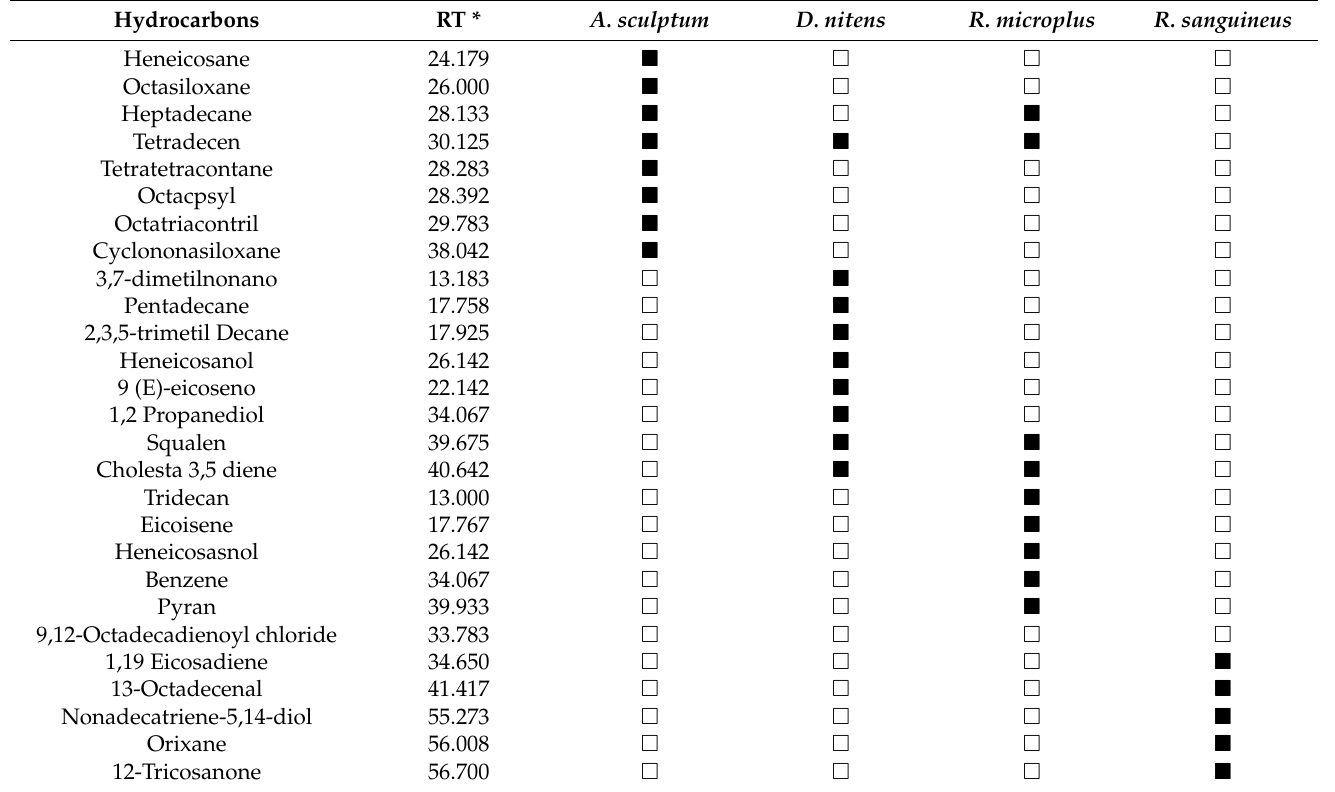
Table 1. Hydrocarbons identified from the cuticles of the ixodid ticks: Amblyomma sculptum , Dermacen- tor nitens, Rhipicephalus microplus and Rhipicephalus sanguineus s.l. Cuticular hydrocarbons with more than 2% abundance of the total peaks revealed by gas chromatography are listed below: ( (cid:4) ) detected, ( (cid:3) ) not